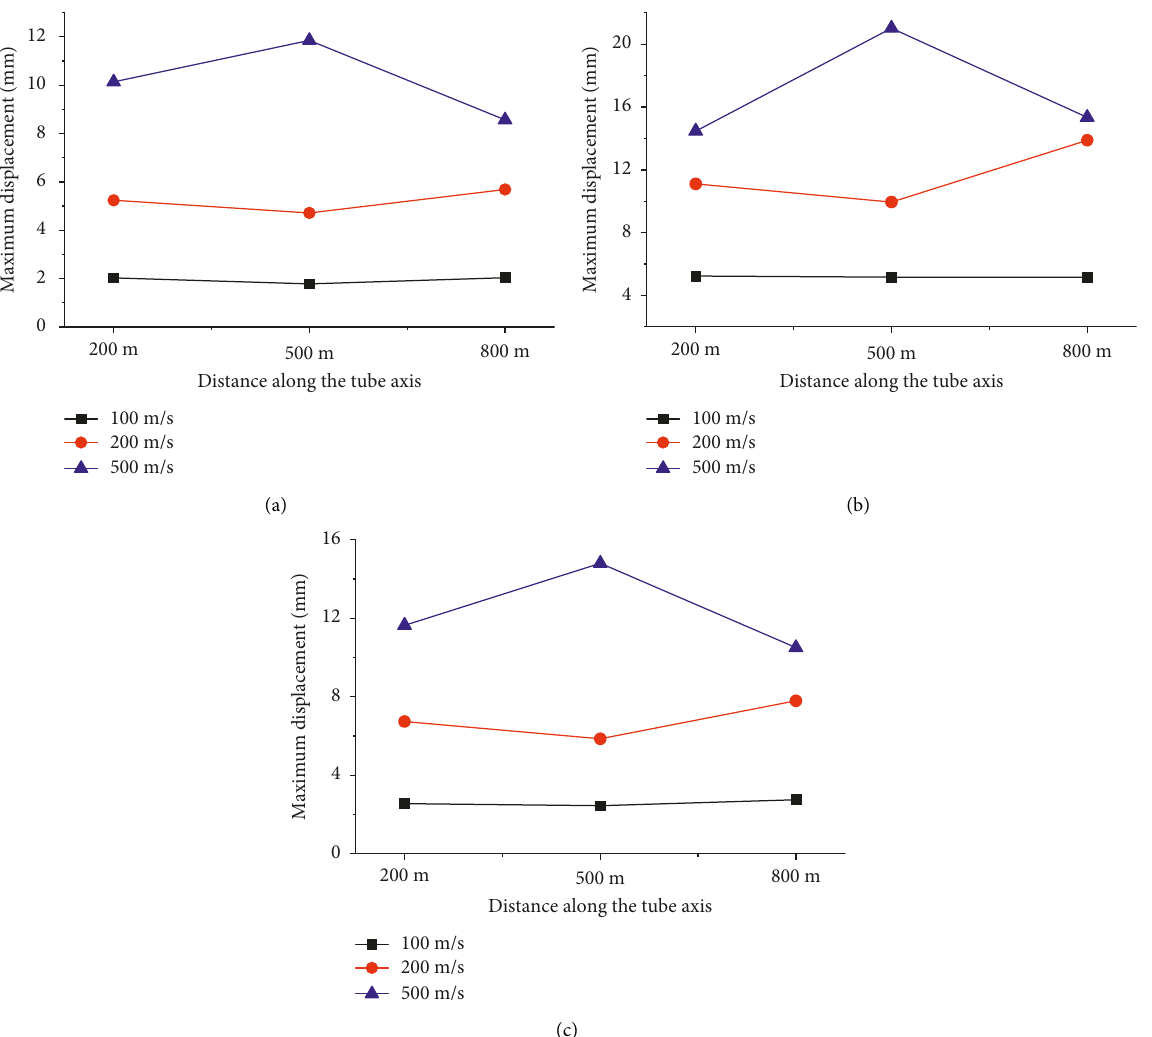
Figure 5: Maximum value of longitudinal vibration displacement of the pipeline under different wave velocities. (a) Normal, (b) vacant, and (c) polymer grouting